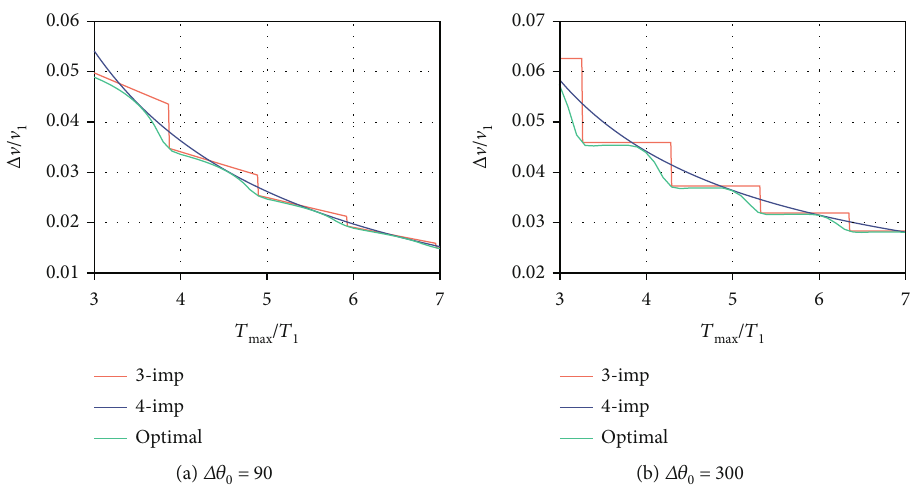
∈ ½ 3 T (cid:2) . The transfer is either internal , 7 T max 1 1